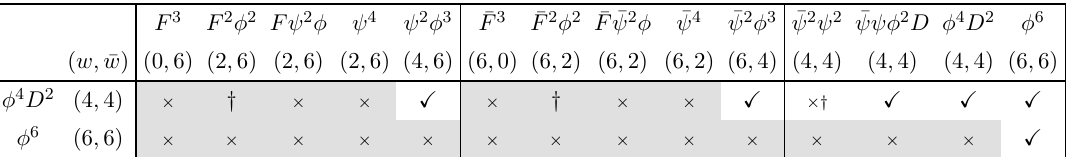
Table 3 . Interplay between the SMEFT matrix of anomalous dimensions and the renormalization scale dependence of Wilson coe(cid:14)cients for the real singlet scalar. The rows correspond to opera- tor categories with tree-level Wilson coe(cid:14)cients for the real singlet scalar, which may or may not renormalize the operator category indicated in each column at one loop. The ( w; (cid:22) w ) refer to the ‘holomorphic weights’ de(cid:12)ned in [55]. The shaded entries indicate cases where the operator category in question is not renormalized by one of the tree-level operators due to the non-renormalization the- orems of [55], in agreement with [51]. The (cid:2) labels indicate cases where the operator in question is not renormalized by one of the tree-level operators because there are no diagrams [57]. These general results are consistent with the logarithmic renormalization scale dependence of Wilson coe(cid:14)cients for the singlet scalar: the X labels denote operator categories with one-loop Wilson coe(cid:14)cients that depend logarithmically on the renormalization scale, while the y labels denote operator categories with one-loop Wilson coe(cid:14)cients that are strictly independent of the renormalization scale. The entry marked ‘ (cid:2)y ’ refers to the case where there is no one-loop diagram in the EFT; however, there may still be a (cid:12)nite one-loop contribution to the operator coe(cid:14)cient from a mixed diagram in the UV theory, cf. our discussion at the end of section